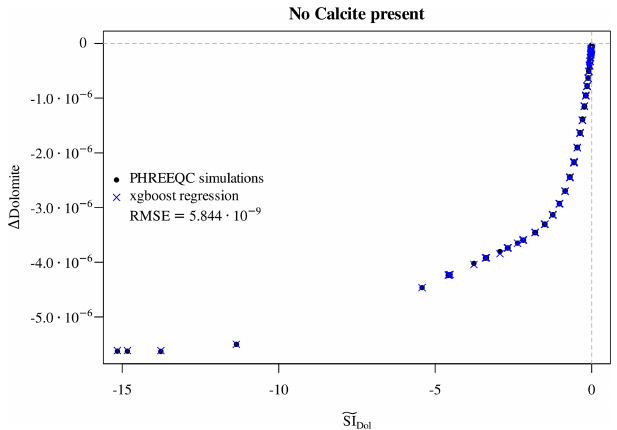
Figure 7. Regression of (cid:49) dolomite vs. estimated (cid:101) SI Dol for the cases in which no calcite is initially present. The multivariate regressor makes use of the predictors (cid:102) SR Dol , pH, C, Cl, Mg, and